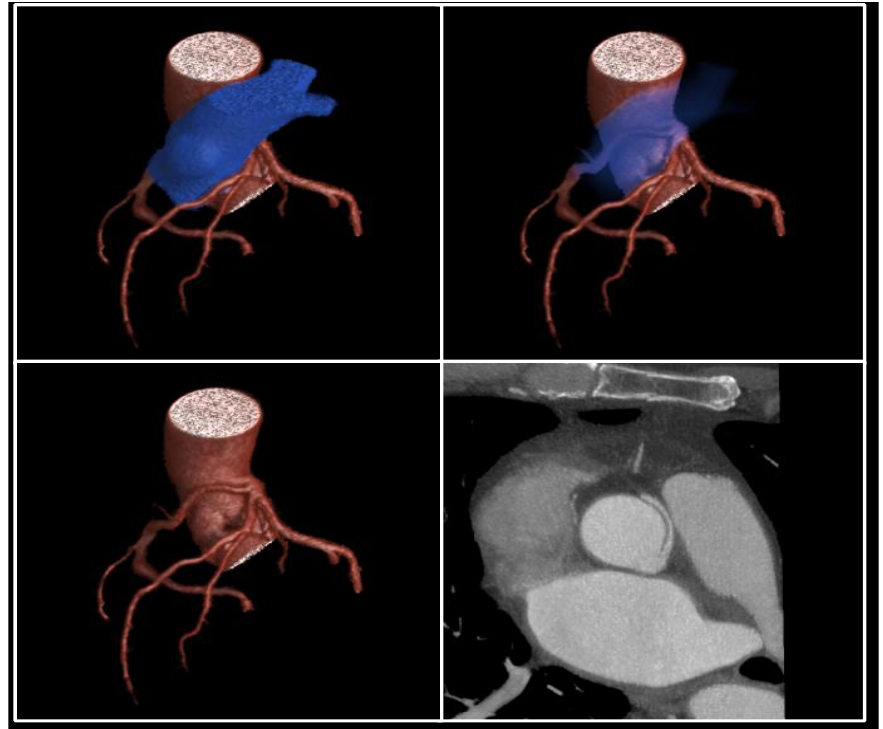
Figure 3. 3D volume rendered images of CTCA in patient showing ( a ) RCA originating from LMS with inter-arterial course; ( b ) rendering with effacement of pulmonary artery and cross-sectional study.